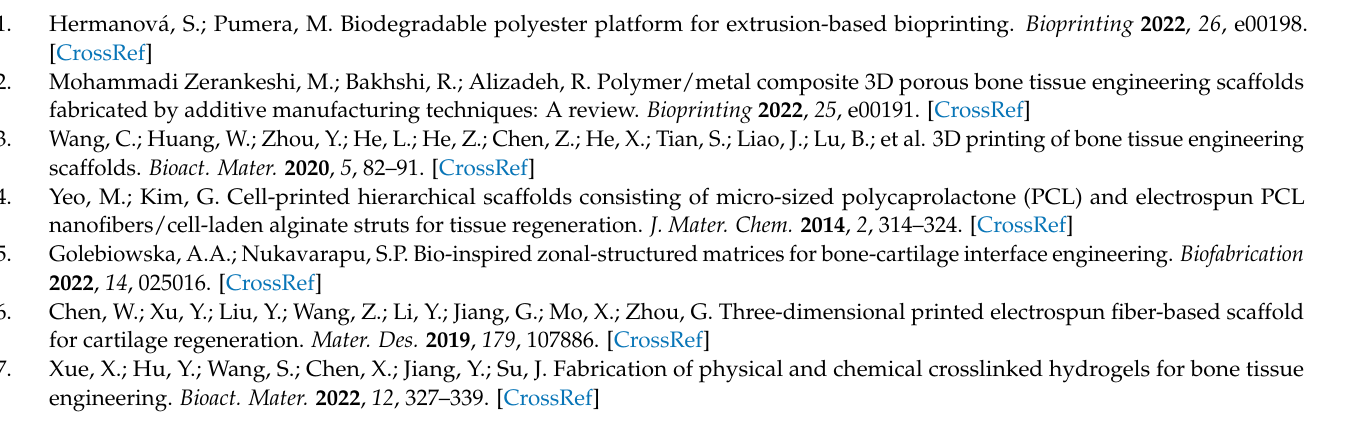
PCL scaffolds. Figure S2: Optical microscope images of PCL hybrid scaffolds. Figure S3: Cell culture on hybrid PCL scaffolds. Table S1: Bio-Rad PrimePCR primers for real time